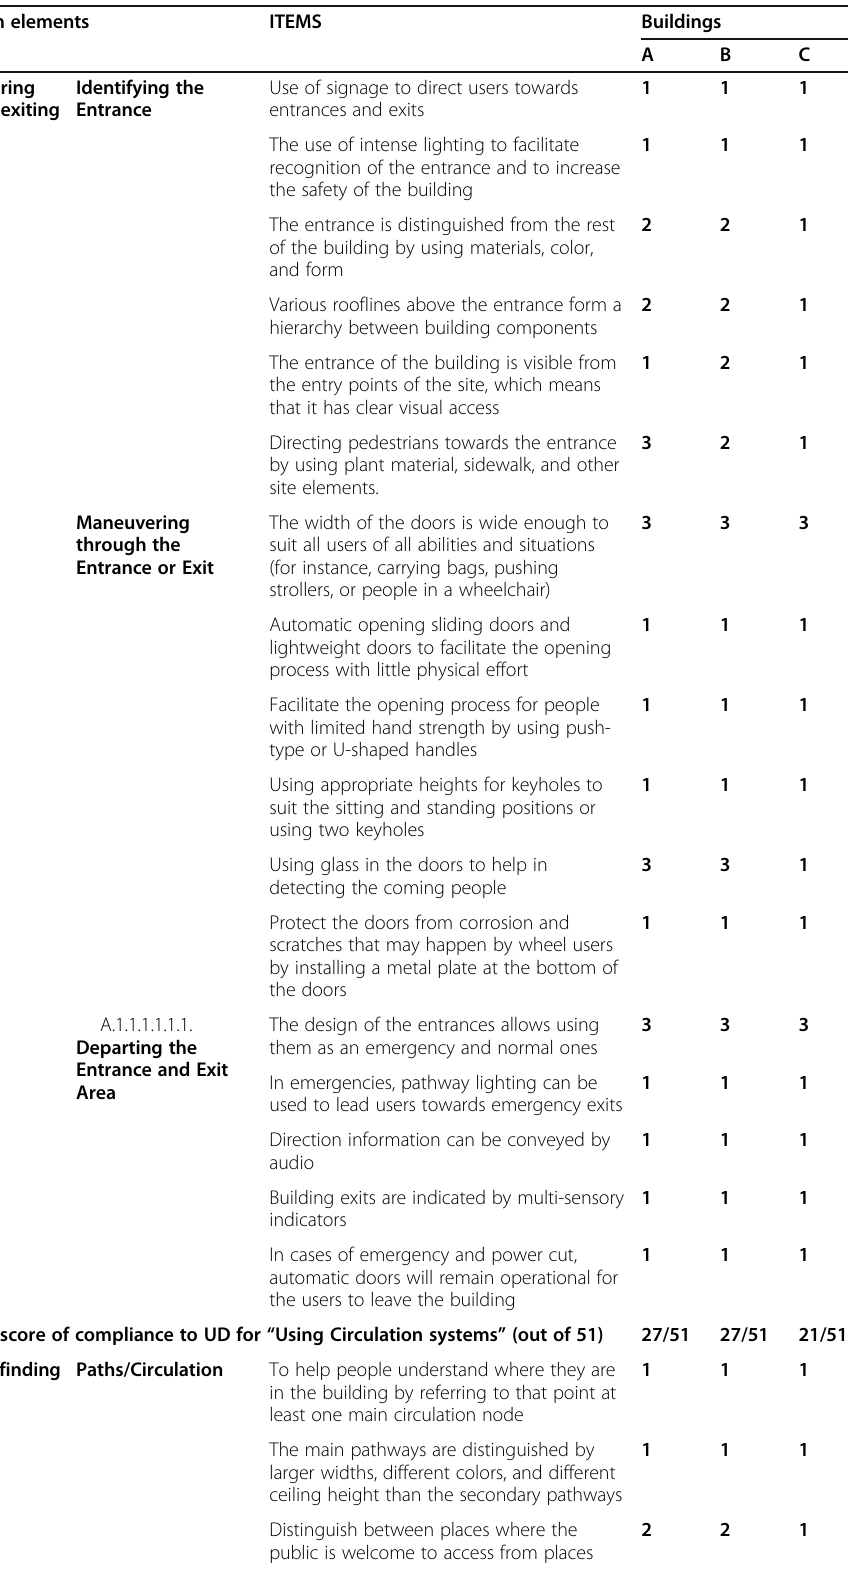
Table 3 The score of compliance to UD for each element and item in the three buildings (Continued) Main